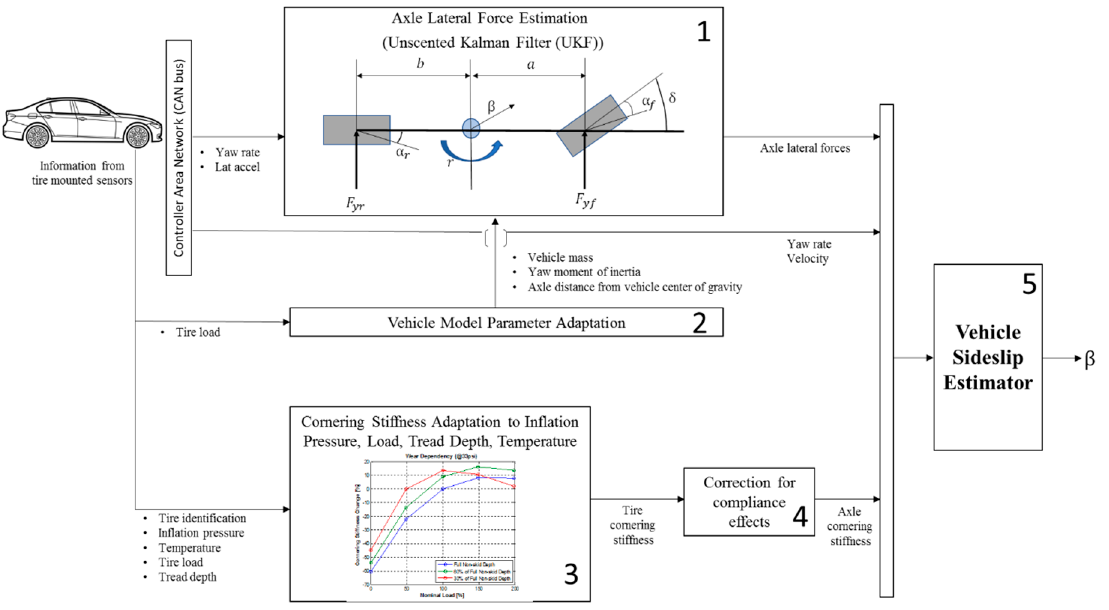
Figure 22. Block diagram of the proposed approach for vehicle sideslip angle estimation.